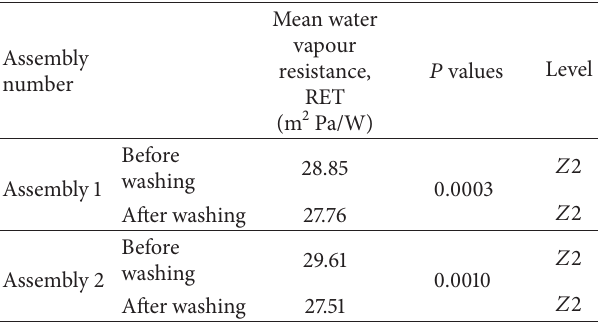
Table 5: Water vapour resistance test results of multilayered fabric